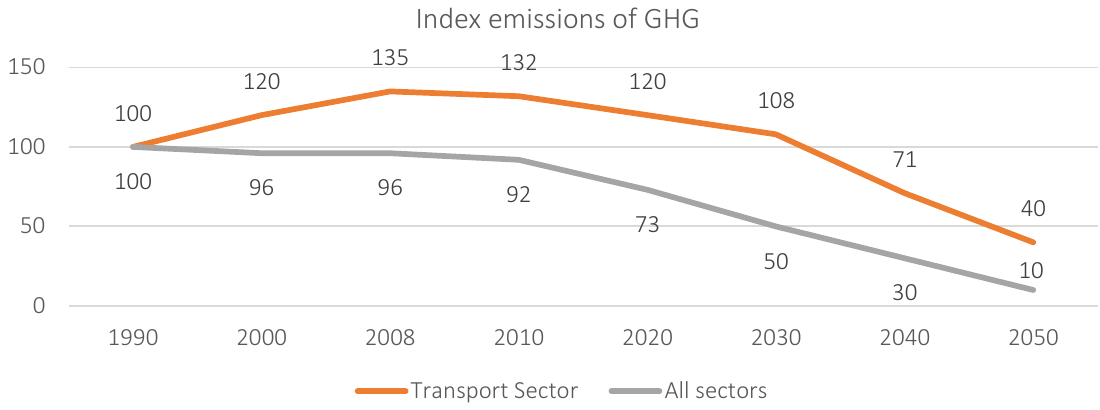
Figure 1. Targets for emissions of GHG for transport and all